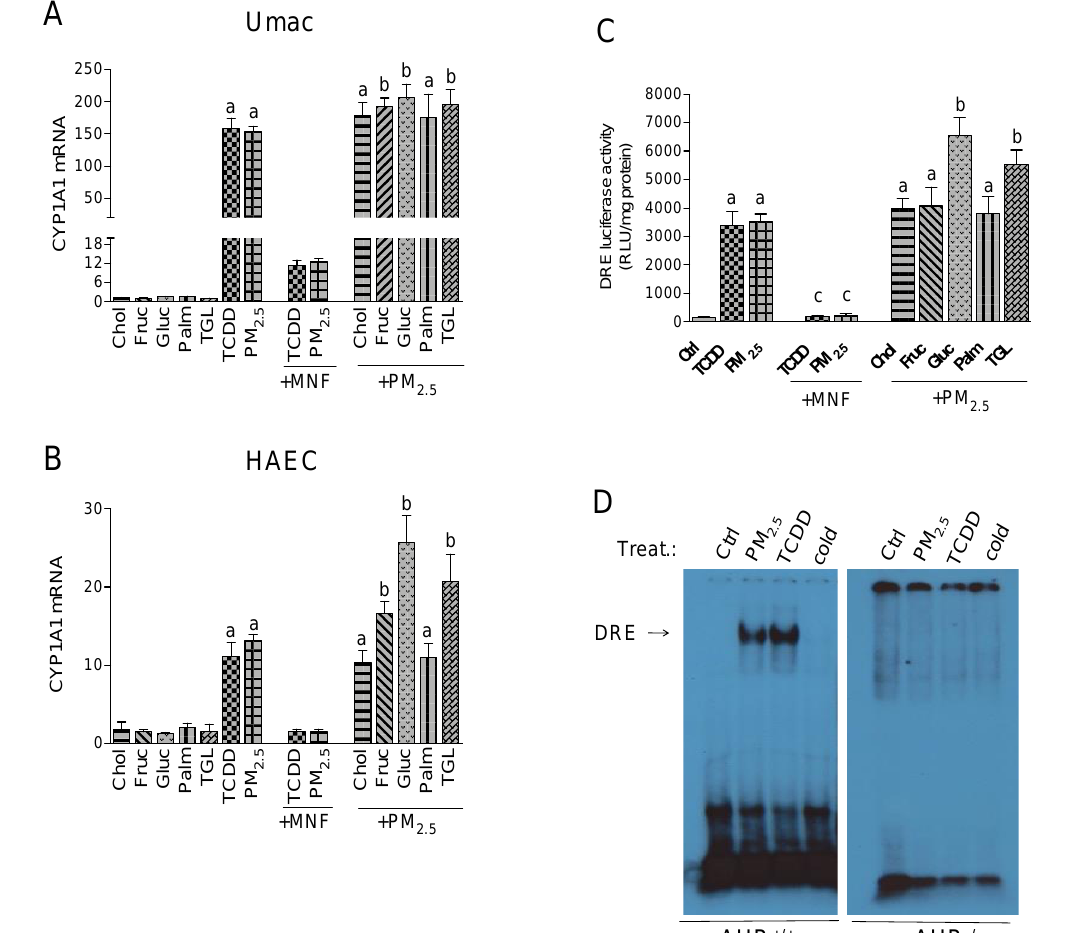
Figure 1. E ff ect of nutritional compounds on tetrachlorodibenzo-p-dioxin (TCDD)- and particulate matter (PM 2.5 )-induced cytochrome P450 (CYP)1A1 expression and Aryl Hydrocarbon Receptor (AHR) activity. ( A ) U937-derived macrophages (Umac) and ( B ) human aortic endothelial cells (HAEC) were treated with cholesterol (Chol, 10 µ g / mL), fructose (Fruc, 25 mM), glucose (Gluc, 25 mM), palmitic acid (Palm, 5 µ M), triglyceride (TGL, 10 µ g / mL), TCDD (1 nM), and PM 2.5 (10 µ g / mL) for 24 h. Cells were treated with 3-methoxy-4-nitroflavone (MNF) (5 µ M) to block activation of AHR by TCDD and PM 2.5 . The e ff ect of nutritional factors on CYP1A1 was tested in presence of PM 2.5 . The mRNA expression of CYP1A1 and the housekeeping ß-actin was analyzed by qPCR. Control cells were treated with the corresponding vehicle. ( C ) E ff ect of nutritional compounds on PM 2.5 -induced dioxin responsive element (DRE) luciferase activity. Umac were transiently transfected with a DRE luciferase reporter construct for 24 h and then treated with TCDD or PM 2.5 in presence or absence of MNF for 16 h. The e ff ect of nutritional factors on DRE activity was tested in presence of PM 2.5 ; a significantly higher than Ctrl; b significantly higher than cells treated with PM 2.5 only; c significantly lower than cells treated with TCDD or PM 2.5 only; p < 0.05; ( D ) PM 2.5 -induced AHR binding activity. Bone marrow-derived macrophages (BMM) from AHR +/+ and AHR − / − mice were treated for 1 h with 10 µ g / mL of PM 2.5 , cells were also treated with 1 nM TCDD as a positive control. Nuclear proteins were extracted and incubated with 32 P-labeled oligonucleotides containing the consensus site of DRE and loaded on a native gel for gel-mobility shift assay (GMSA). A 100-fold excess of the unlabeled specific (cold) DRE oligonucleotides was added to confirm specificity.